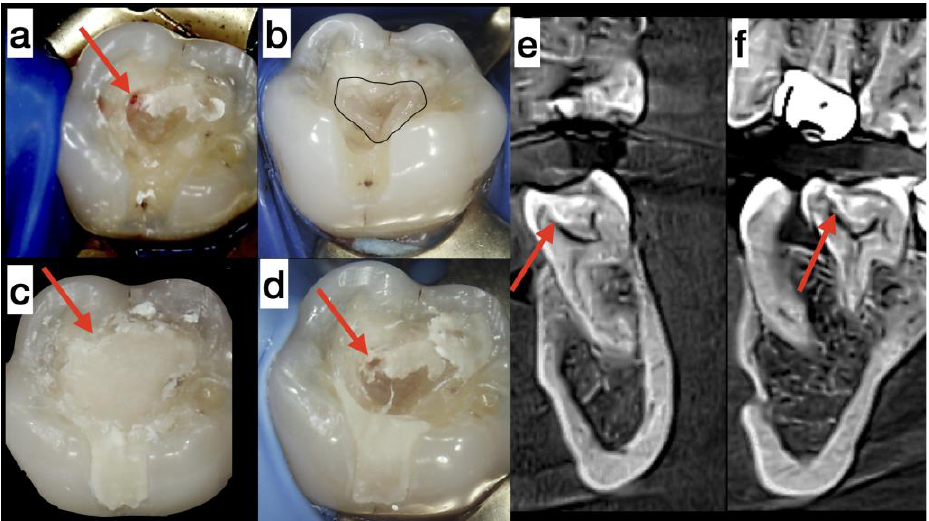
Figure 1. ( a ) Cavity without carious dentin — the red arrow indicates the communication with the dental pulp. ( b ) Application of A-PRF+ membrane on the pulp wound. ( c ) Application of a glass ionomer cement. ( d ) The communication with the pulp was covered by reparative dentin three months later. ( e ) Cone beam computed tomography (CBCT) of tooth 36 after treatment at the coronal section — the red arrow indicates dentin bridge. ( f ) CBCT of tooth 36 after treatment of the sagittal section — the red arrow indicates dentin bridge.